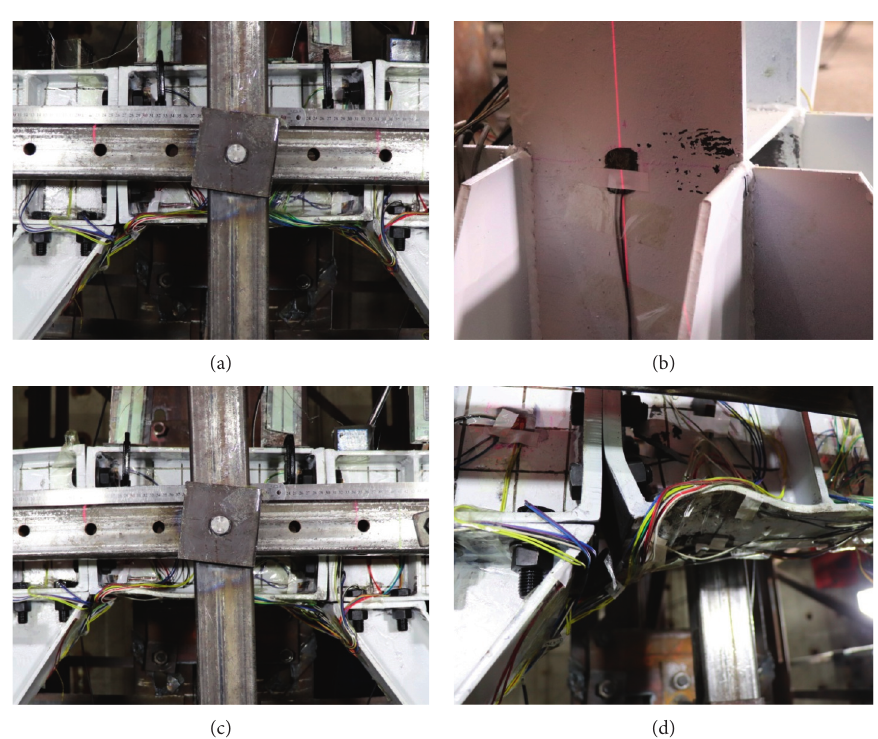
Figure 12: Experimental phenomena of specimen PDKB-1. (a) Deformation at 4 δ (d) Deformation at 9 δ y